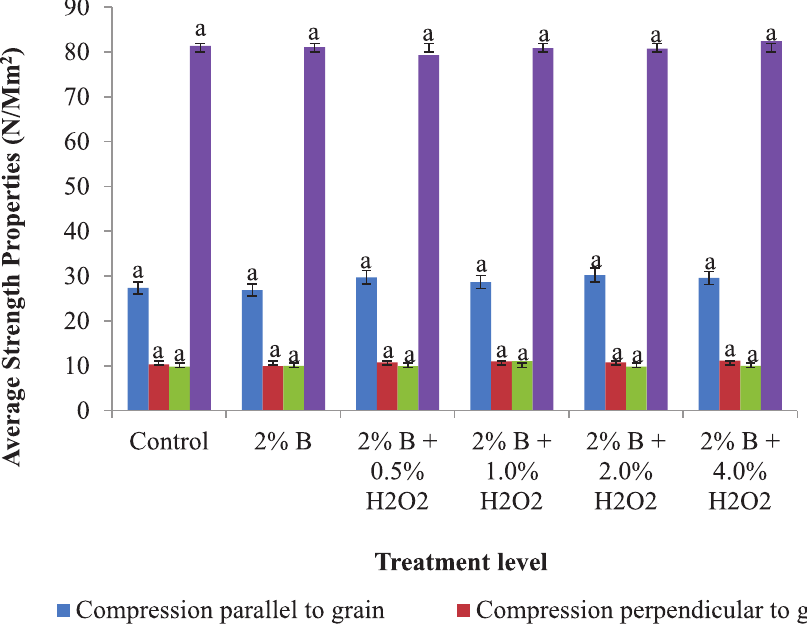
Figure 3 - Average compression parallel to grain, compression perpendicular to grain, shear parallel to grain and tension parallel to grain of bleached rubberwood at different treatment level. means within column followed by the same letter are not significantly different at the 5% level of anOva test. Error bar represents the standard